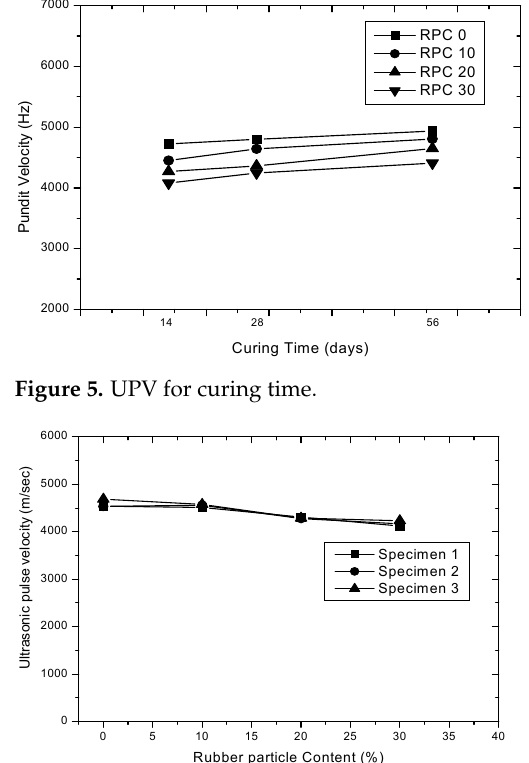
Figure 6. UPV for rubber particle content.